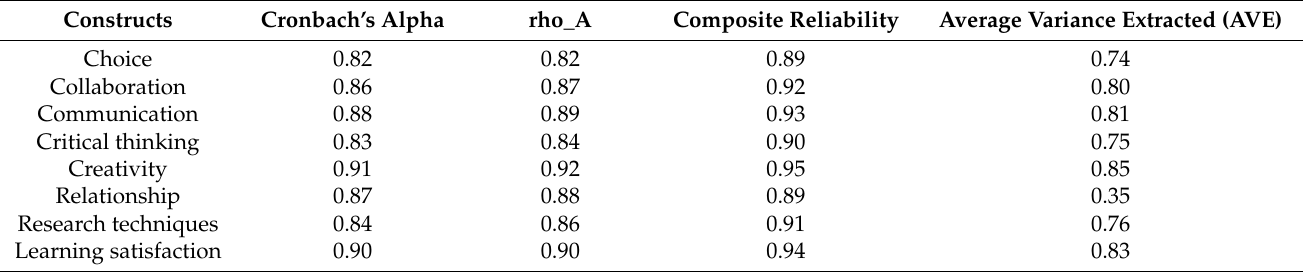
Table 2. Construct Reliability and Validity [40].